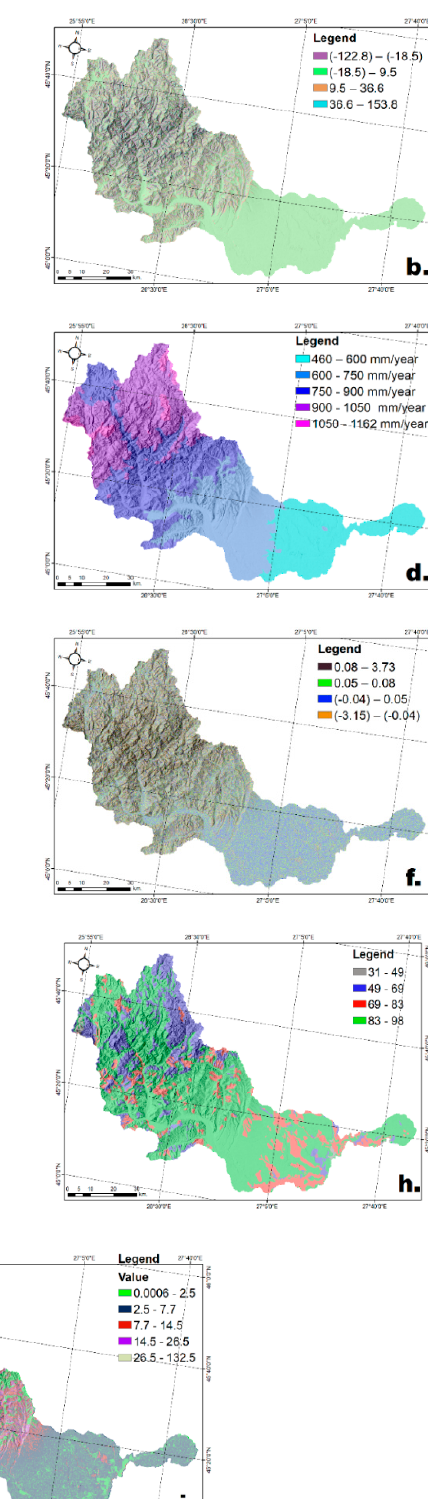
Figure 3. ( a ) Slope, ( b ) elevation, ( c ) hydrological soil group (HSG), ( d ) slope aspect, ( e ) elevation above channel, ( f ) distance from rivers, ( g ) saturated hydraulic conductivity, ( h ) land use, ( i ) drainage density.